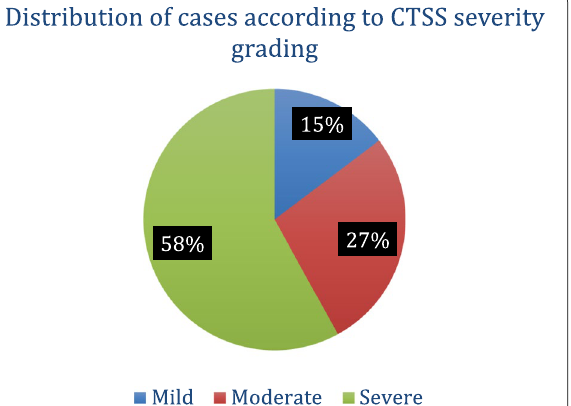
Fig. 5 Distribution of cases according to CTSS severity grading